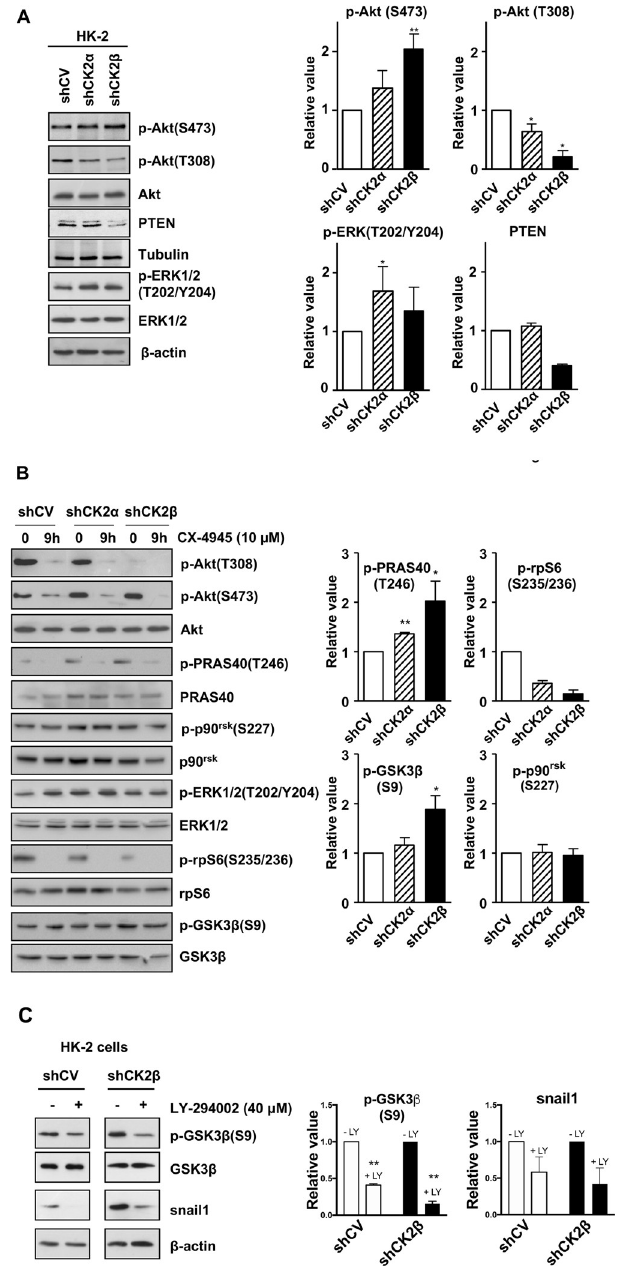
Fig 3. Effect of CK2 subunit down-regulation and CK2 inhibition on ERK and Akt signalling pathway components. (A) HK-2 control and silenced cells were lysed, and protein extracts were analysed by western blot using the indicated specific antibodies. Tubulin and/or β -actin were used as loading controls. (B) HK-2 control and silenced cells were seeded and treated with 10 μ M of CX4945 for 9 h, then lysed and protein extracts analysed by western blot with the indicated antibodies against components of the PI3K/Akt/mTOR and ERK1/2 signalling